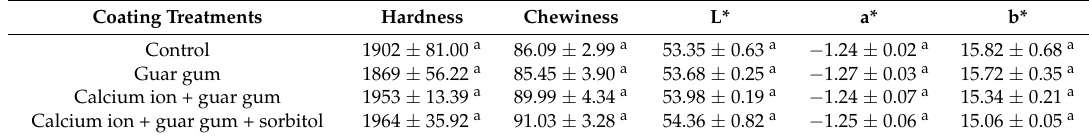
Table 3. Effect of coating on texture and color of French